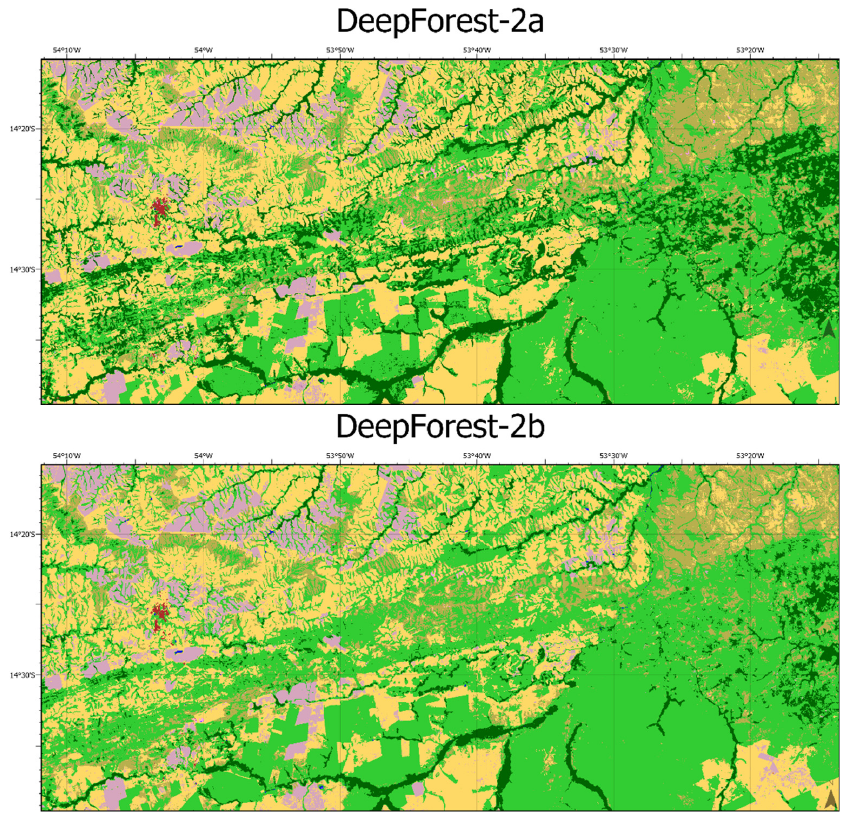
Figure 10. Classification maps produced with the presented representation fusion models DeepForest ‐ 2a/b. The legend for these maps is presented in Figure 8.